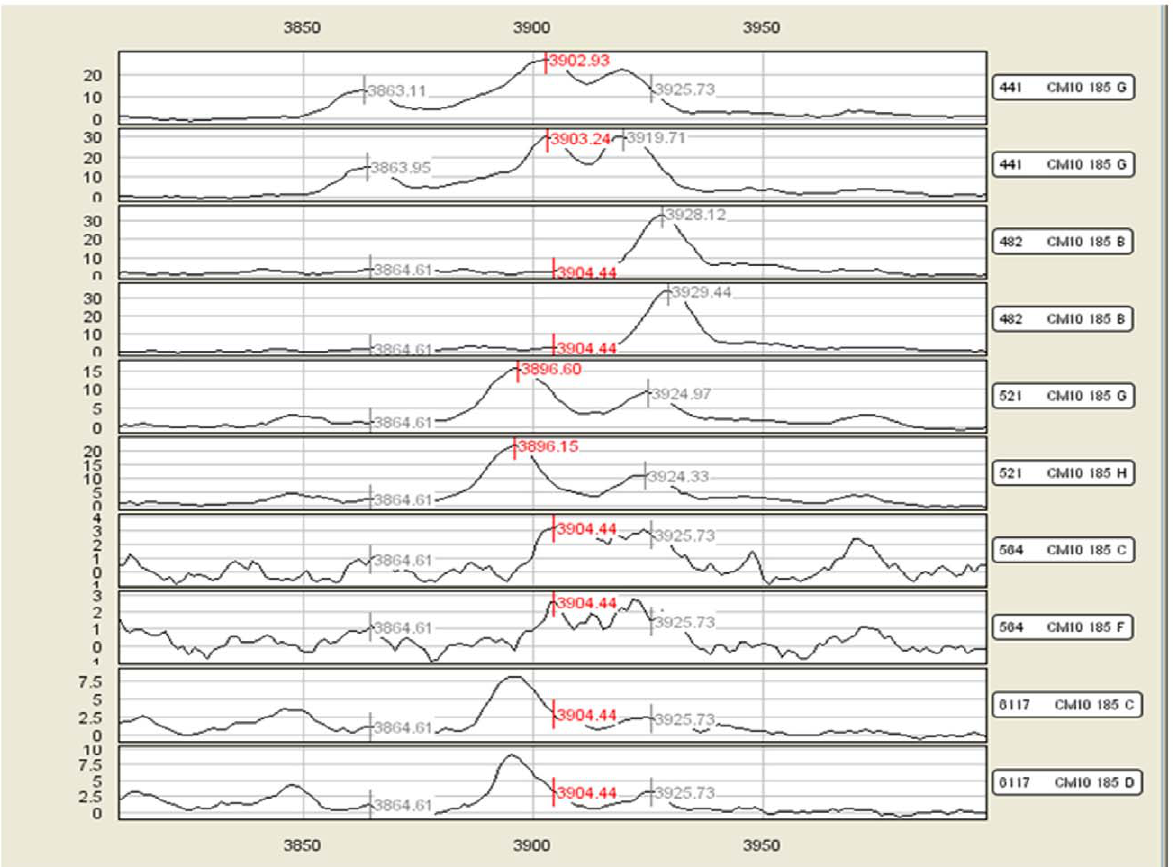
Figure 6. An example peak cluster output from Ciphergen Express v3.5. doi:10.1371/journal.pone.0048103.g006 PLOS ONE |